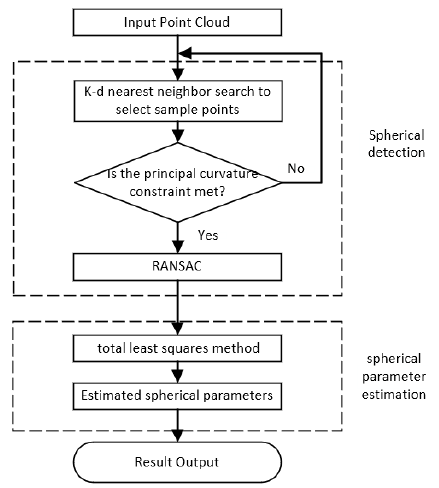
Figure 2. Algorithm flow chart.